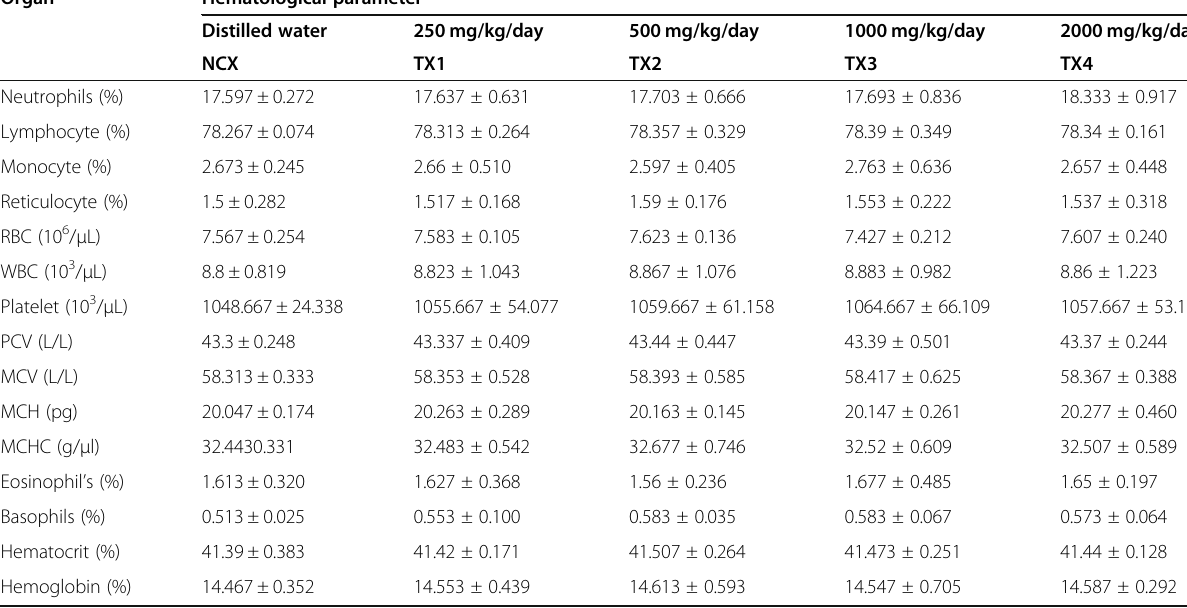
Table 5 Effect of polyherbal combination (PHC) on hematological parameter